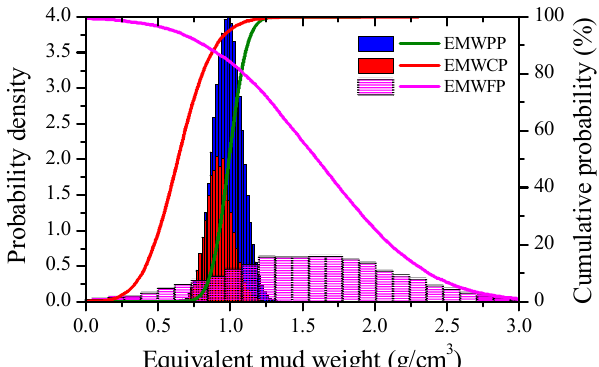
( b ) Figure 19. Influence of pore pressure variance on EMWPP. ( a ) Influence of variance of pore pressure; ( b ) EMWCP varies with variance. 4.5. Uncertainty Analysis of SMWW On the basis of the uncertainty analysis of EMWCP, EMWFP and EMWPP, the cumulative probability of SMWW can be obtained, and the results were shown in Figures 20 and 21 and Table 4.